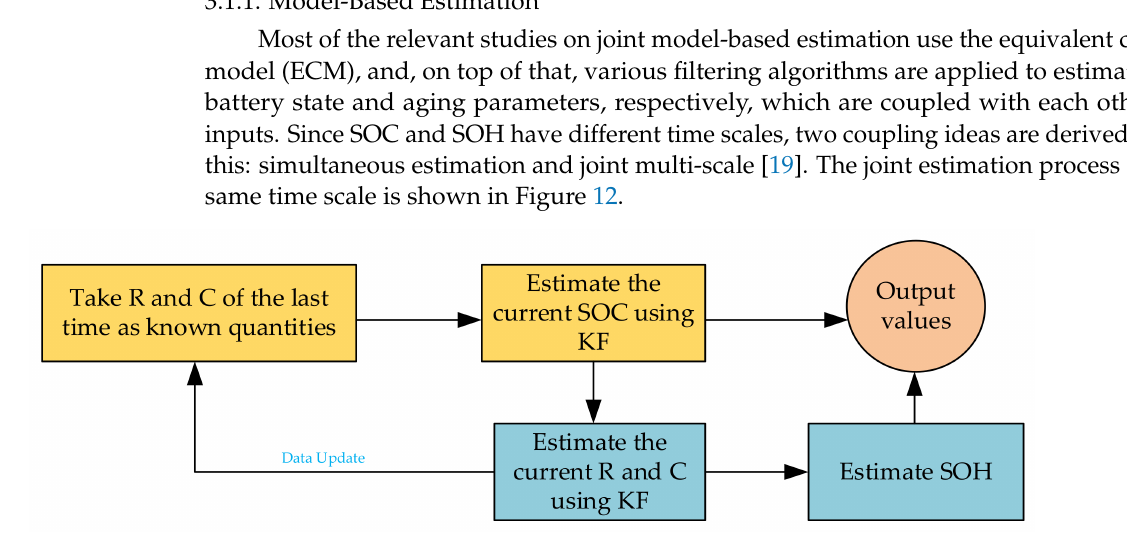
Figure 12. Joint estimation process at the same time